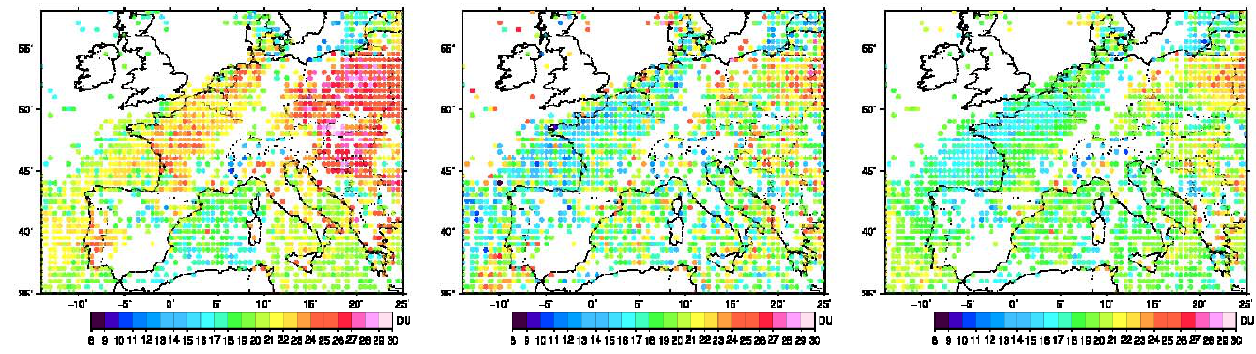
Fig. 4. 0–6km ozone partial columns (Dobson Units) from the mean of the forecast ensemble (i.e. before assimilation; left panel), IASI (central panel) and the mean of analysis ensemble (i.e. the ensemble after assimilation; right panel) for the 17 July 2007 (at 09:00 a.m.). The white points on the maps correspond to the missing pixels (clouds or bad inversion) (color scale varies from black, representing relatively low values, to pink representing relatively high values).